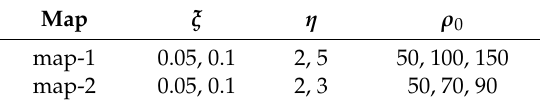
Figure 17. The potential field maps for comparison with water sink model: ( a ) map-1: 30 × 30 size map; and, ( b ) map-2: 60 × 60 size map. Table 2. Parameter set for map-1 and map-2.